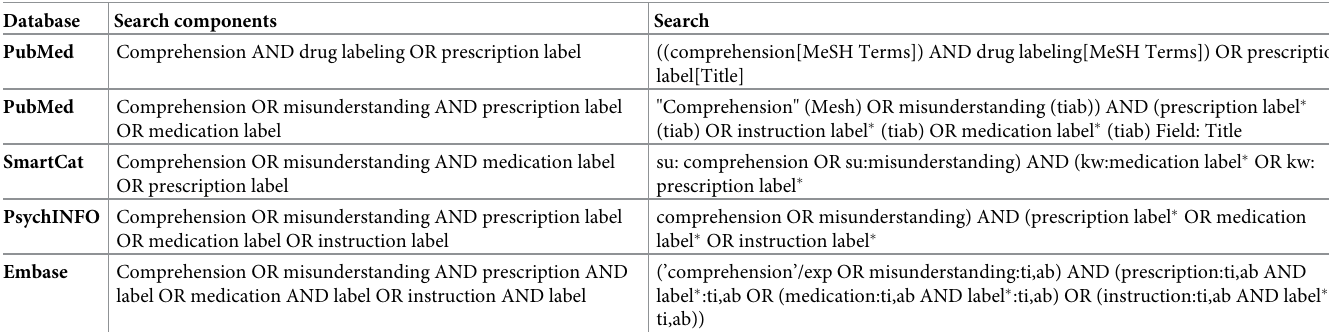
Table 1. Search strategy in electronic